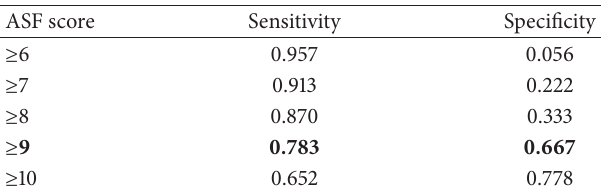
Table 3: Results of ROC analysis with HAM-A total score ≥ 25 as gold standard and ASF score as test